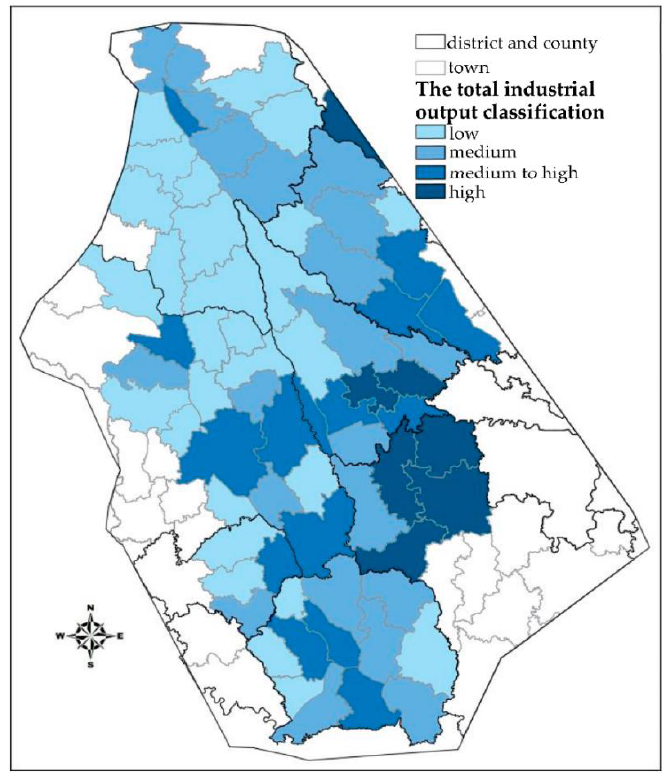
Figure 9. Total industrial output of each unit.